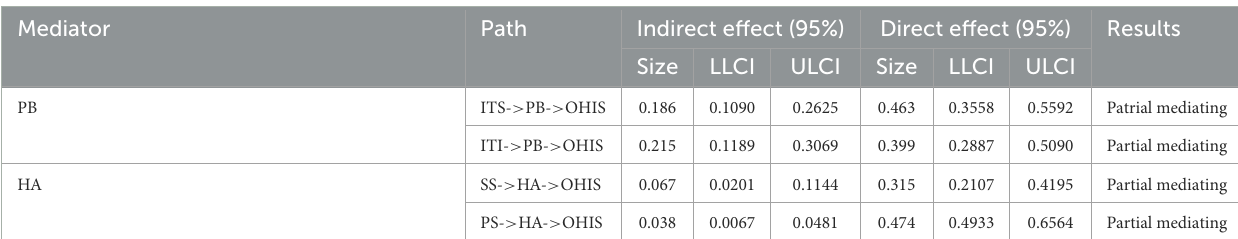
TABLE 4 Mediation effect